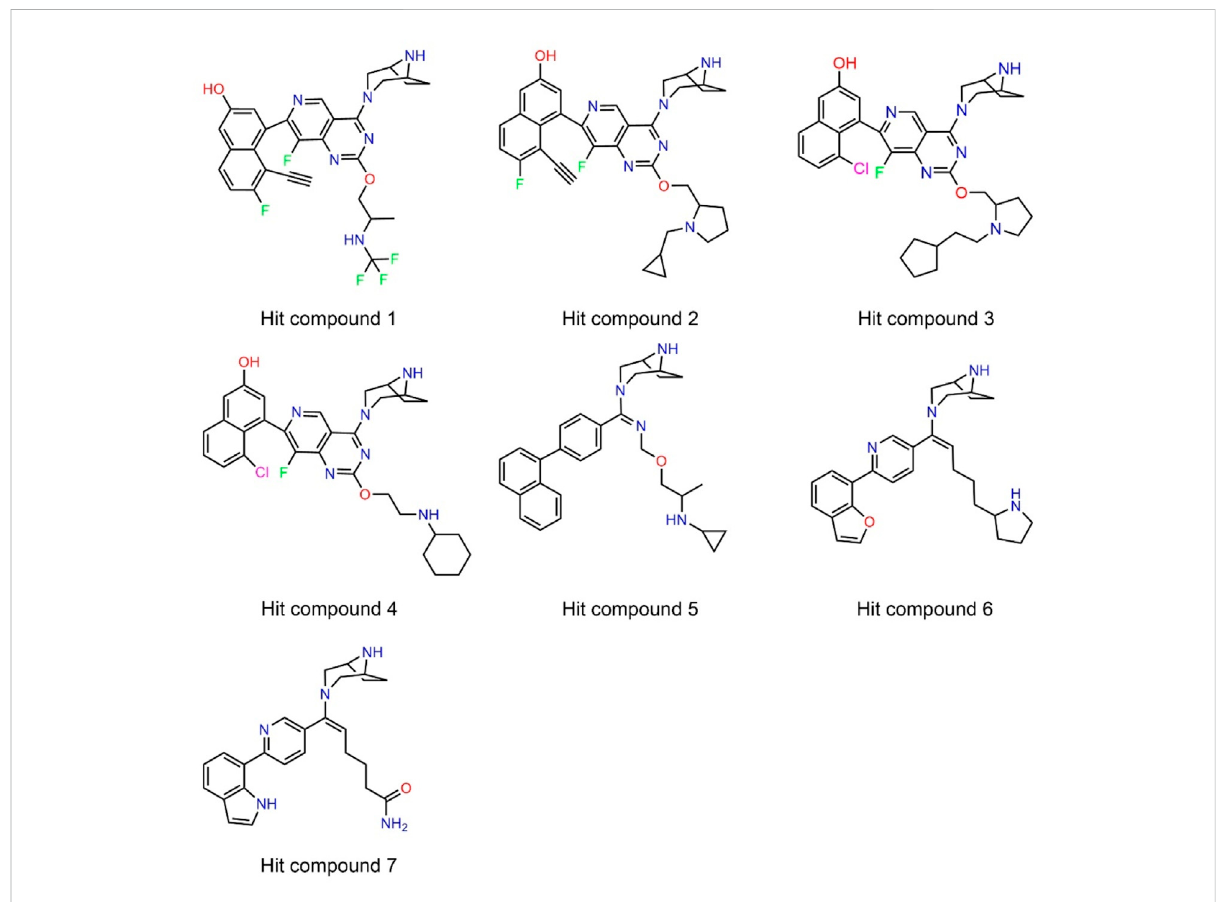
FIGURE 5 The chemical structures of hit compounds 1 –